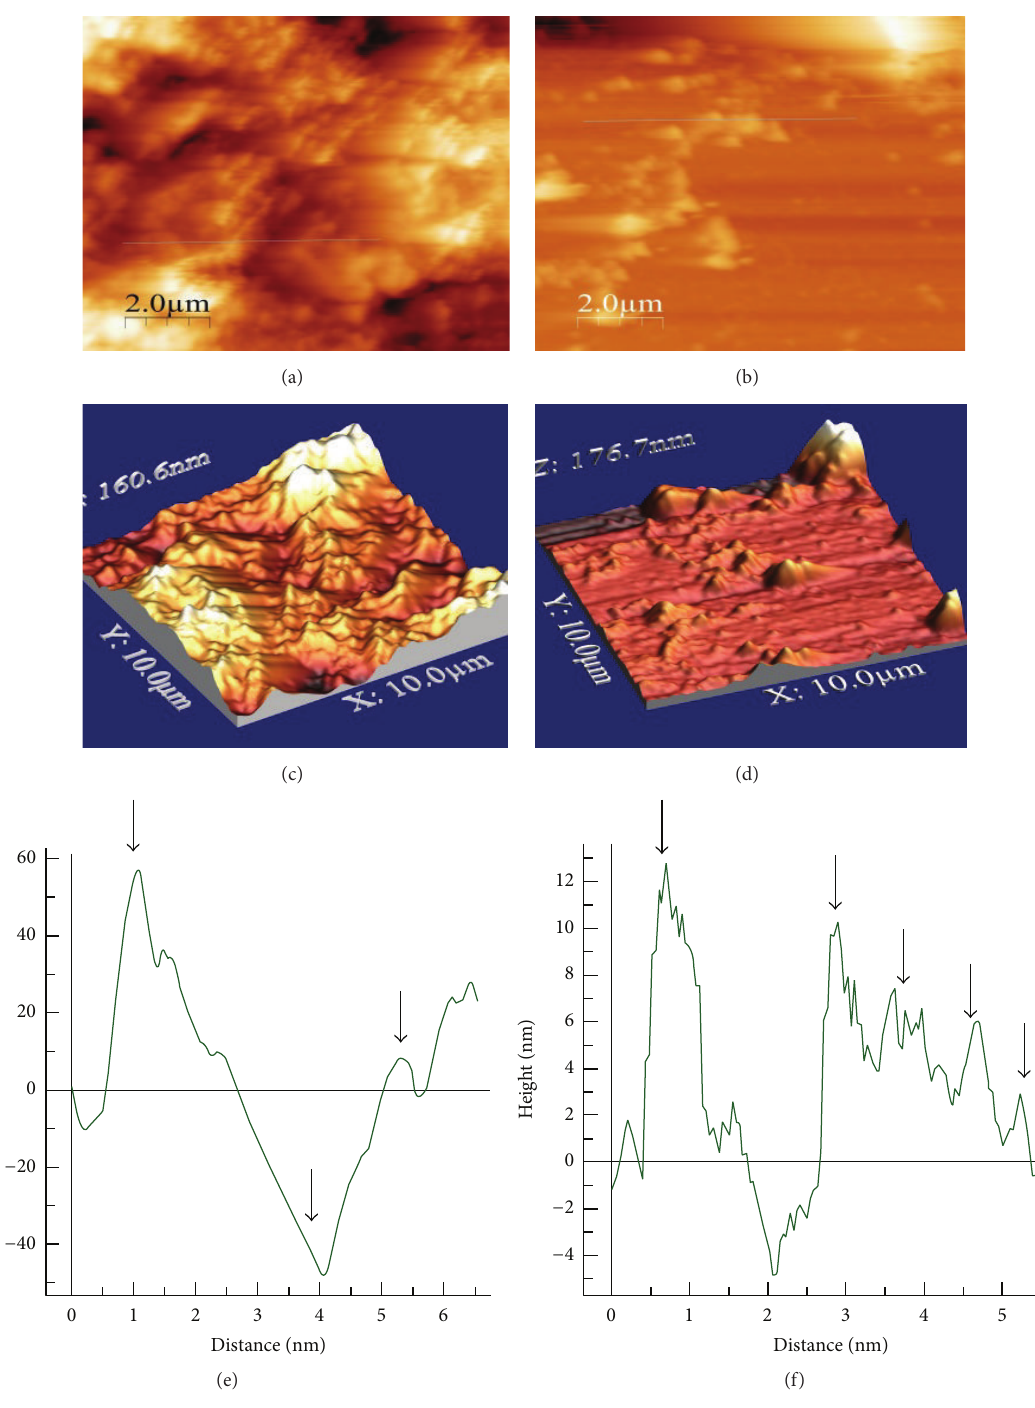
Figure 4: Height variation measurement by 2D and 3D AFM of ACM. (a) 2D AFM of native ACM, (b) 2D AFM of spin coated ACM, (c) 3D AFM of native ACM, (d) 3D AFM of spin coated ACM, (e) line scan to measure the height variations in native ACM, and (f) line scan to measure the height variations in spin coated ACM. Arrows indicate variations in the height of native and spin coated ACM.